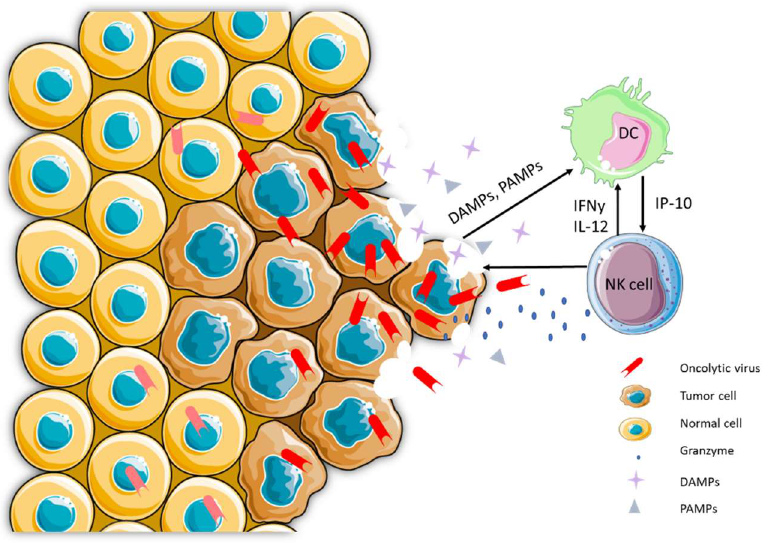
Figure 1. Oncolytic virus (OV)-infected tumor cells reveal tumor associated antigens through immunogenic cell death leading to anti-tumor immune responses. OVs take advantage of impaired antiviral and other essential signaling pathways in tumor cells, resulting in its selective growth advantage in tumor cells, but not in healthy cells. Infection and replication in tumor cells by OVs result in tumor cell lysis and the release of tumor associated antigens in the presence of highly immunogenic pathogen associated molecular pattern (PAMP) and danger associated molecular pattern (DAMP) signatures. This leads to the recruitment of innate and adaptive immune cells and the initiation of anti-tumor immune responses.